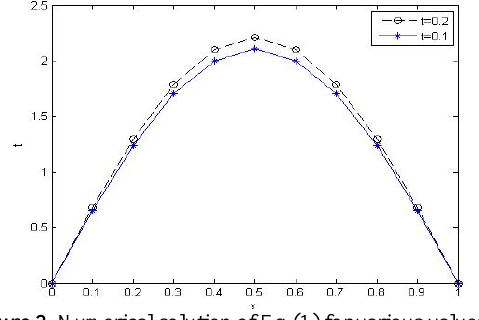
Figure 2. Numerical solution of Eq.(1) for various values of t .